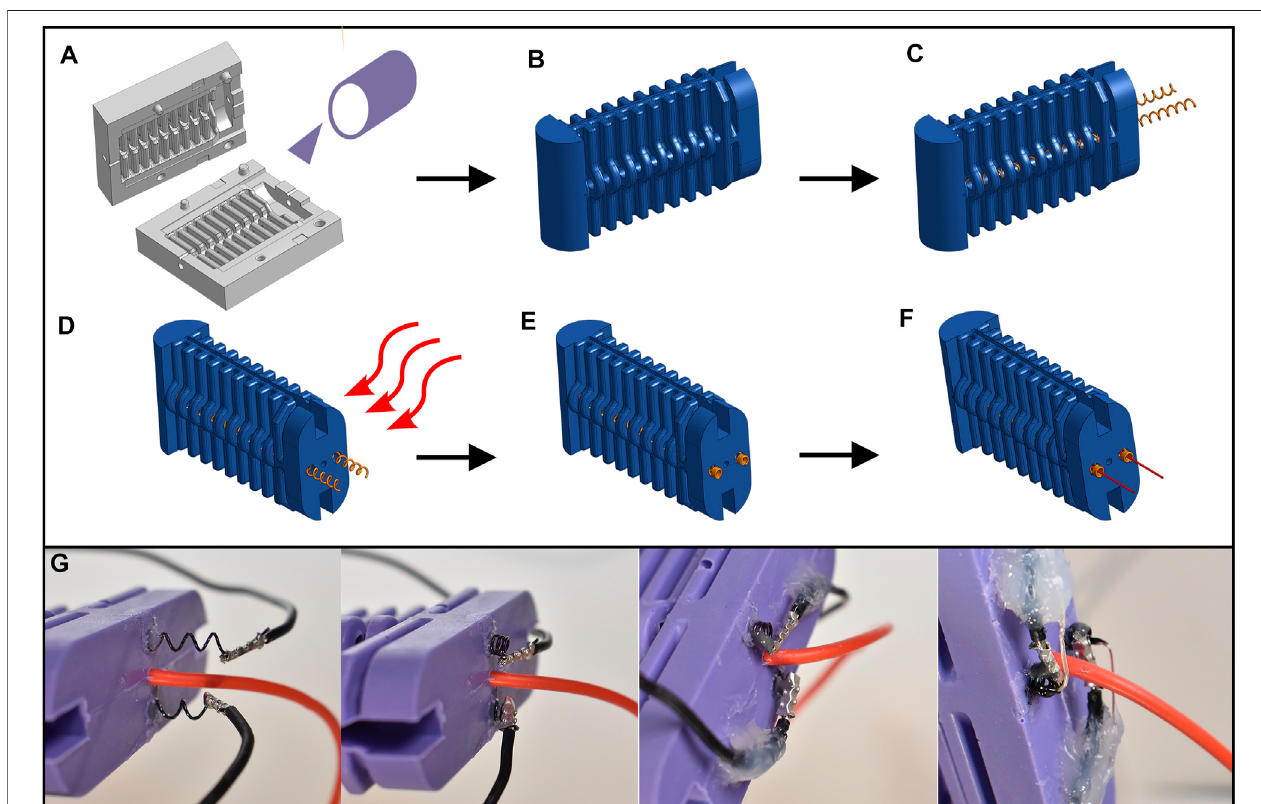
FIGURE2| FabricationprocedureforourSMA-actuatedsoftlimbwithtemperaturesensing. (A) Thelimbiscastfrombulksiliconeusinga3Dprintedmold,then (B) releasedtoformthemainbody. (C) SMAwiresareinsertedandsealedinplacewithadhesive,leavingadditionalturnsofwireextendingouttherear. (D) Heatisappliedto the rear of the limb, so that (E) the extra turns of wire fully actuate. (F) Thermocouples are then adhered into the contracted coils with thermally-conductive epoxy, and experience no further mechanical stress during operation. (G) Fabrication in hardware follows this procedure.